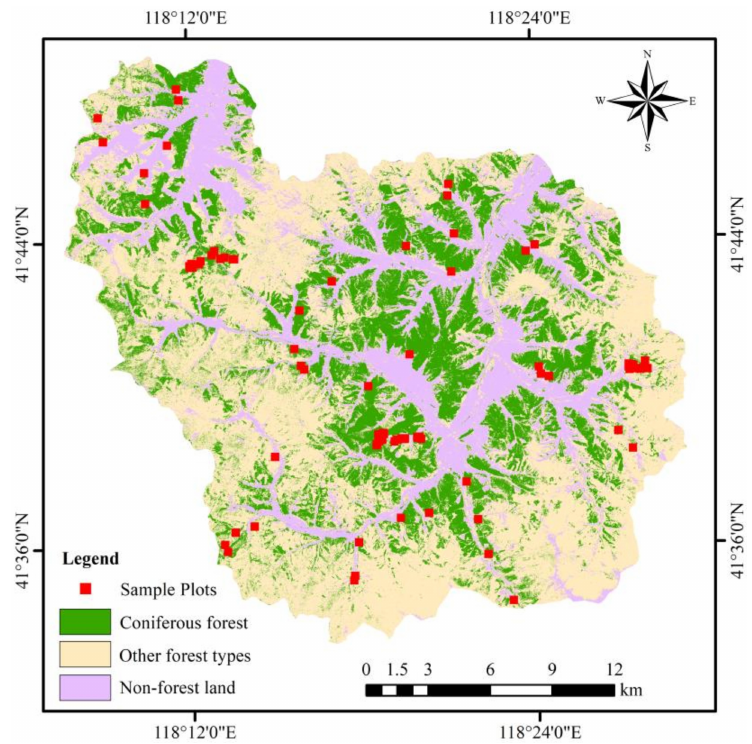
Figure 2. Land-cover types in the Wangyedian forest farm and the spatial distribution of sampled plots. Table 1. Summary statistics of per unit growing stem volume (GSV) values (m 3 / ha).